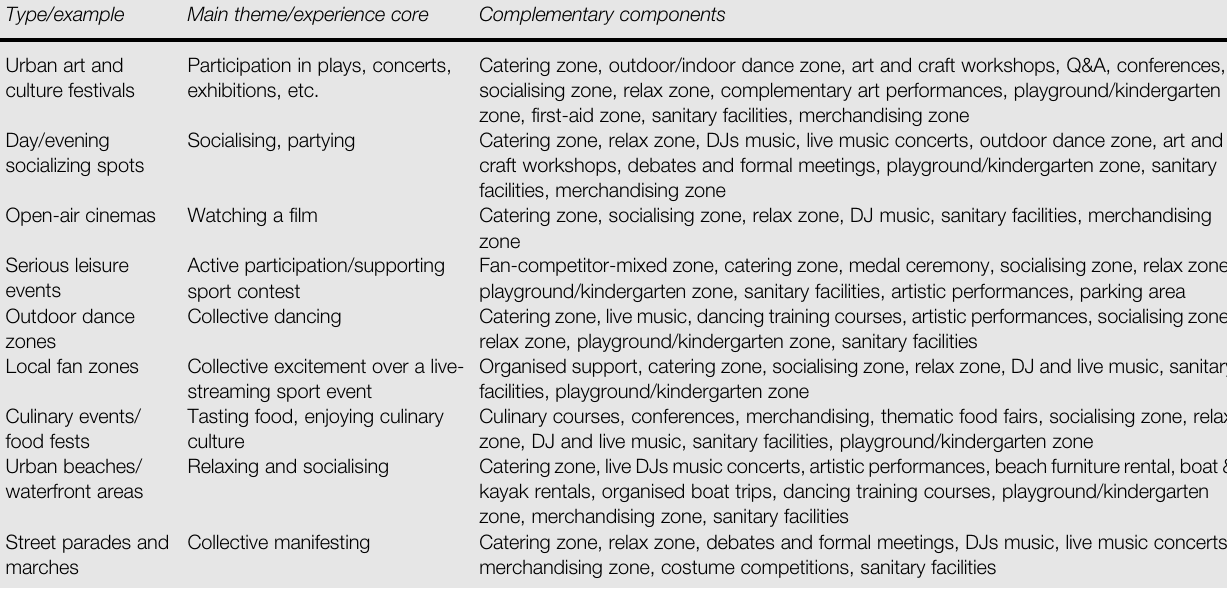
Collective dancing